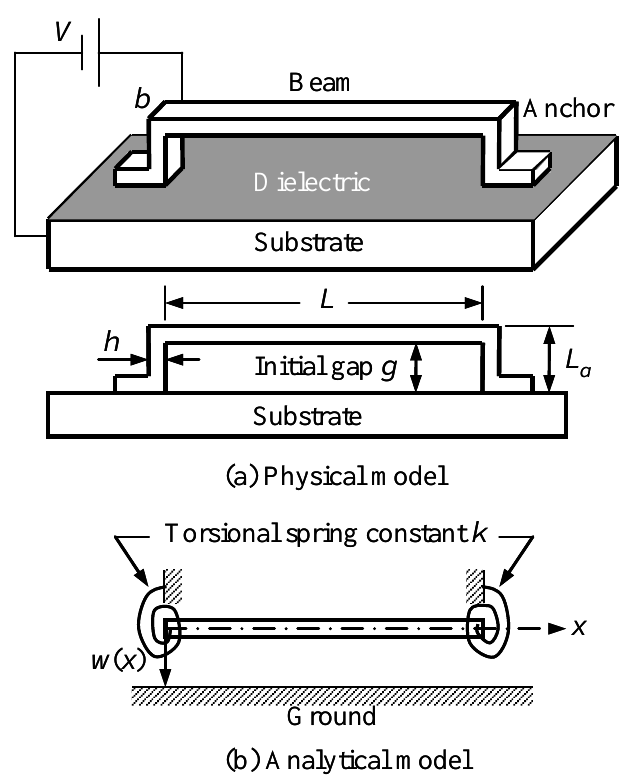
Figure 4. (a) Physical model, (b) Analytical model